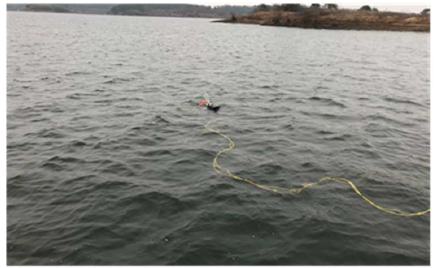
Figure 4. The compensation sailing of the ROV magnetic field measurement system.